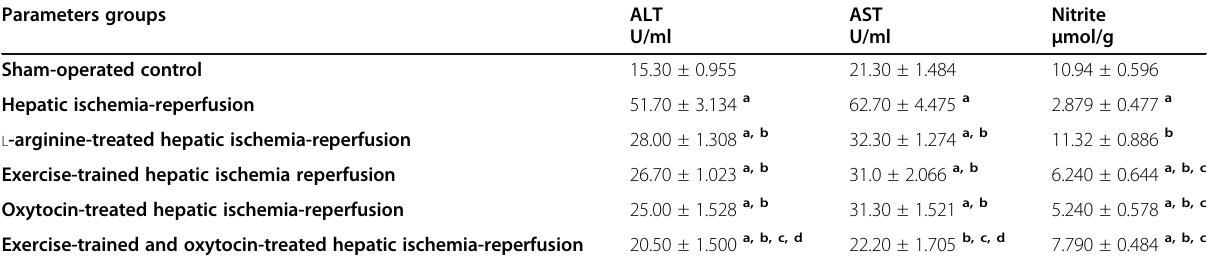
Table 1 Changes in the serum levels of alanine transferase (ALT) and aspartate transferase (AST), and the plasma level of nitrite in the different studied groups